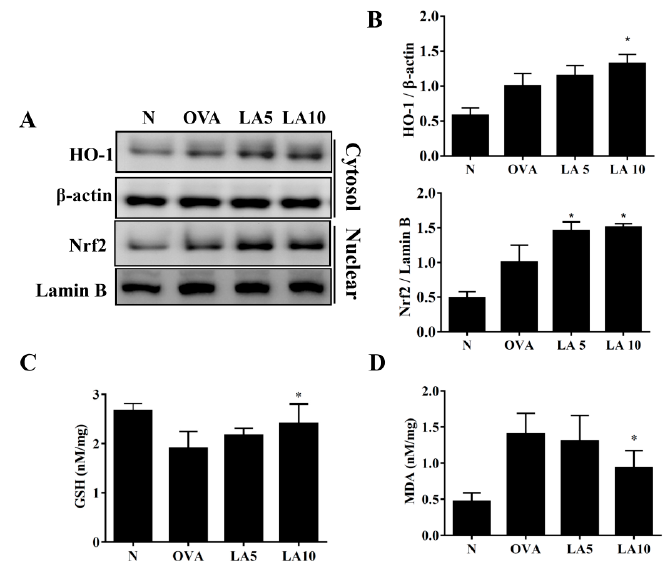
Figure 6. Effects of licochalcone A (LA) on oxidative stress factors. ( A ) Western blot showing LA modulation of HO-1 and Nrf2 expression in lung tissue from normal (N) and OVA-stimulated (OVA) mice with or without licochalcone A (LA5-10) treatment. ( B ) The fold-change in the expression of HO-1 and Nrf2 protein was measured relative to the expression of β -actin and lamin B, respectively. ( C ) Glutathione (GSH) activity and ( D ) malondialdehyde (MDA) activity in mouse lung tissue. Three independent experiments were analyzed, and data were presented as mean ± SEM. * P < 0.05 compared to the OVA control group. ** P < 0.01 compared to the OVA control group.